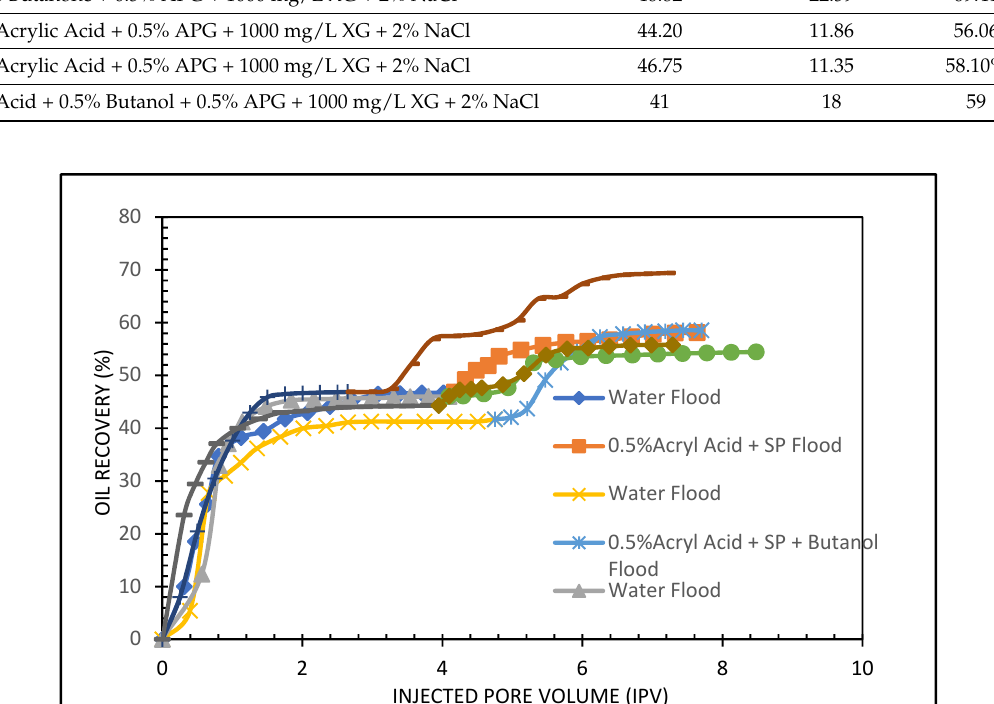
Figure 17. Total oil recovery observed from the five formulations.